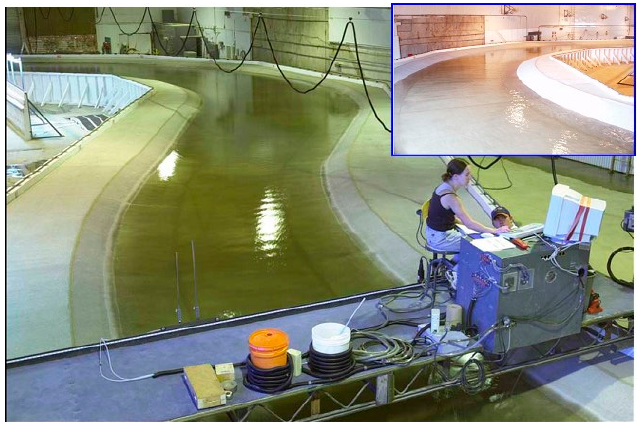
Figure 7. Photograph looking upstream at the Colorado State University (CSU) physical model with flow through two channel curves.